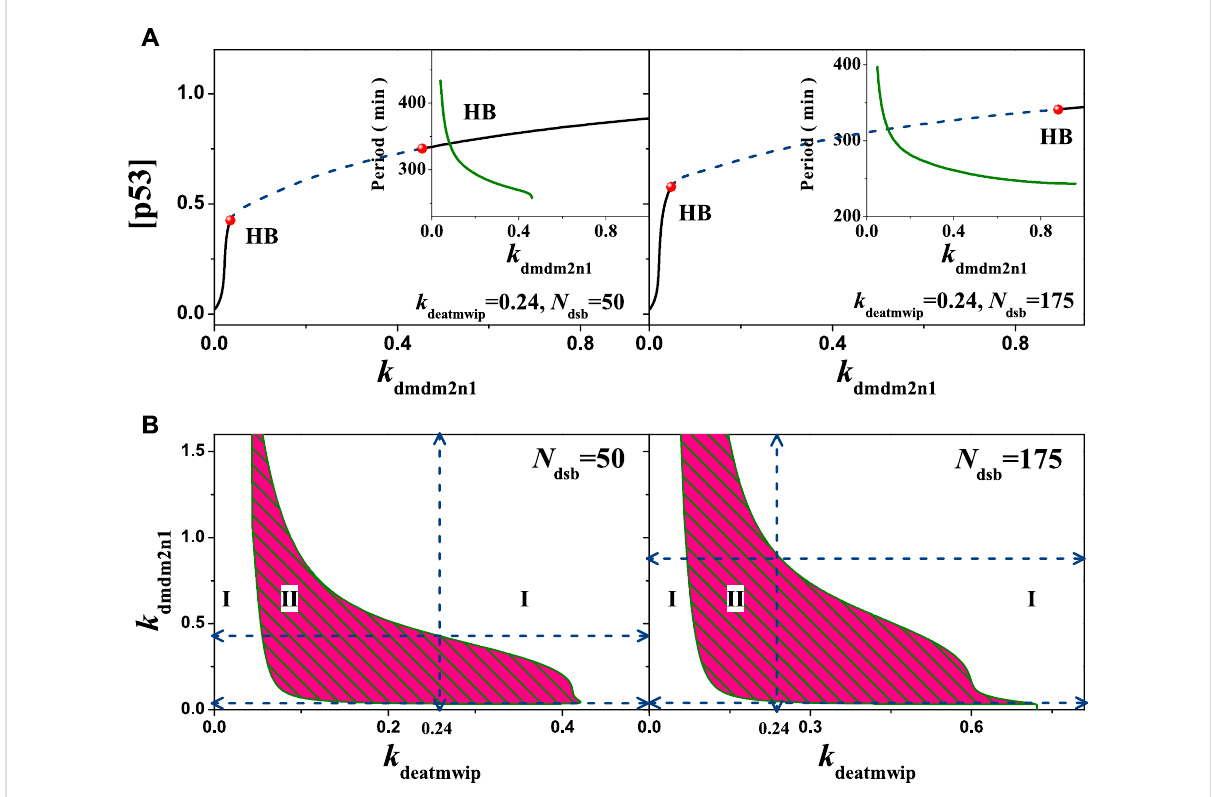
In fl uencesoftheATMregulatedMdm2ndegradationonthenetwork dynamics withdifferentstrengths. (A) Oneparameter bifurcationdiagram of[p53]ontheparameter k dmdm2n1 .Fromlefttoright, k deatmwip =0.15 and0.24respectively. Theschematicdiagramshows therelationship between the period and the parameters k dmdm2n1 . (B) The two-parameter bifurcation with respect to k deatmwip and k dmdm2n1 . The symbols ‘ I ’ , ‘ II ’ and ‘ III ’ representmonostablestate,oscillationstateandexcitedstaterespectively.Fromlefttoright,